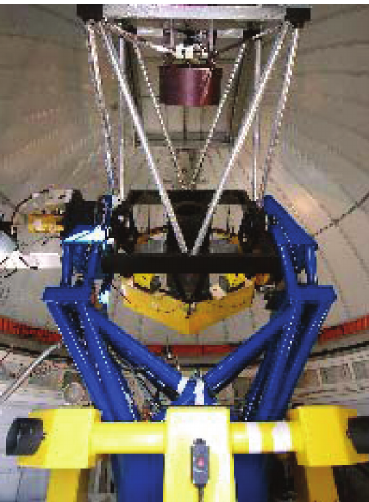
Figure 2: The NMSU 1m alt-az telescope. The Nasmyth port with the CCD camera being on the